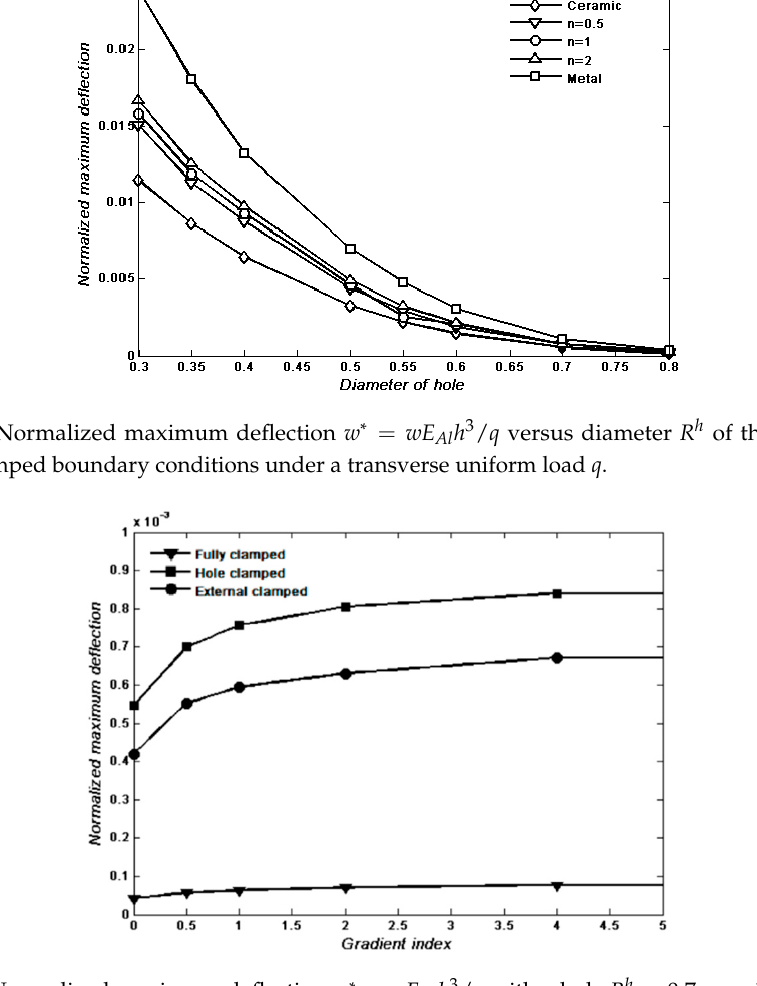
Figure 18. Normalized maximum deflection w ∗ = wE Al h 3 / q with a hole R h = 0.7, ranging with the gradient index under a transverse uniform load q .